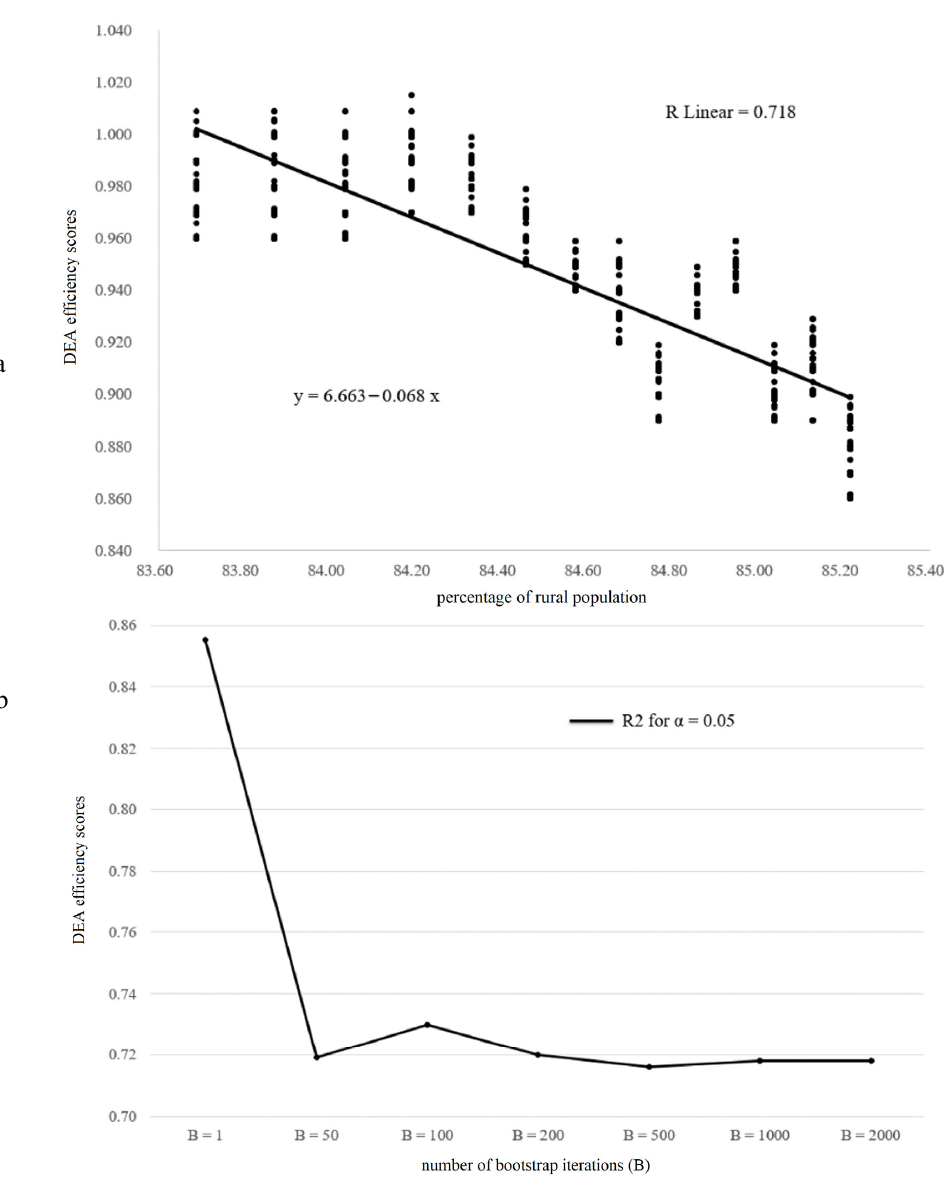
Figure 3. Linear regression model for 2000 bootstraps (upper chart— a ) and development of R 2 (chart below— b ).